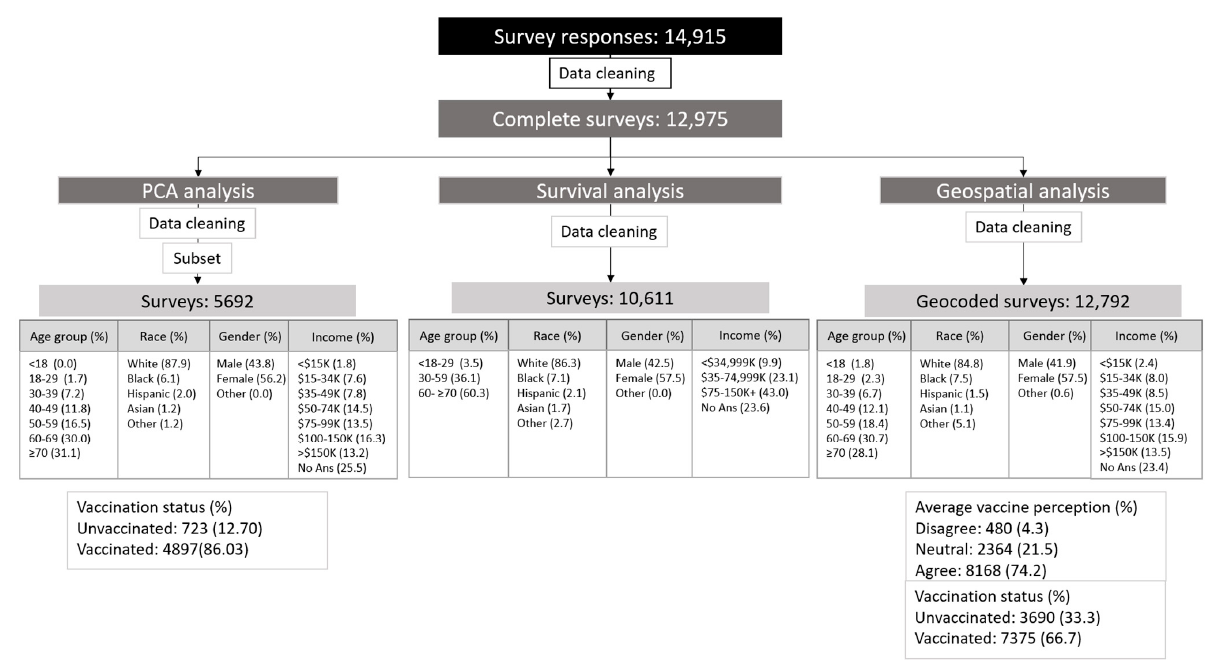
Figure 2. Demographics data and data process for each analysis.